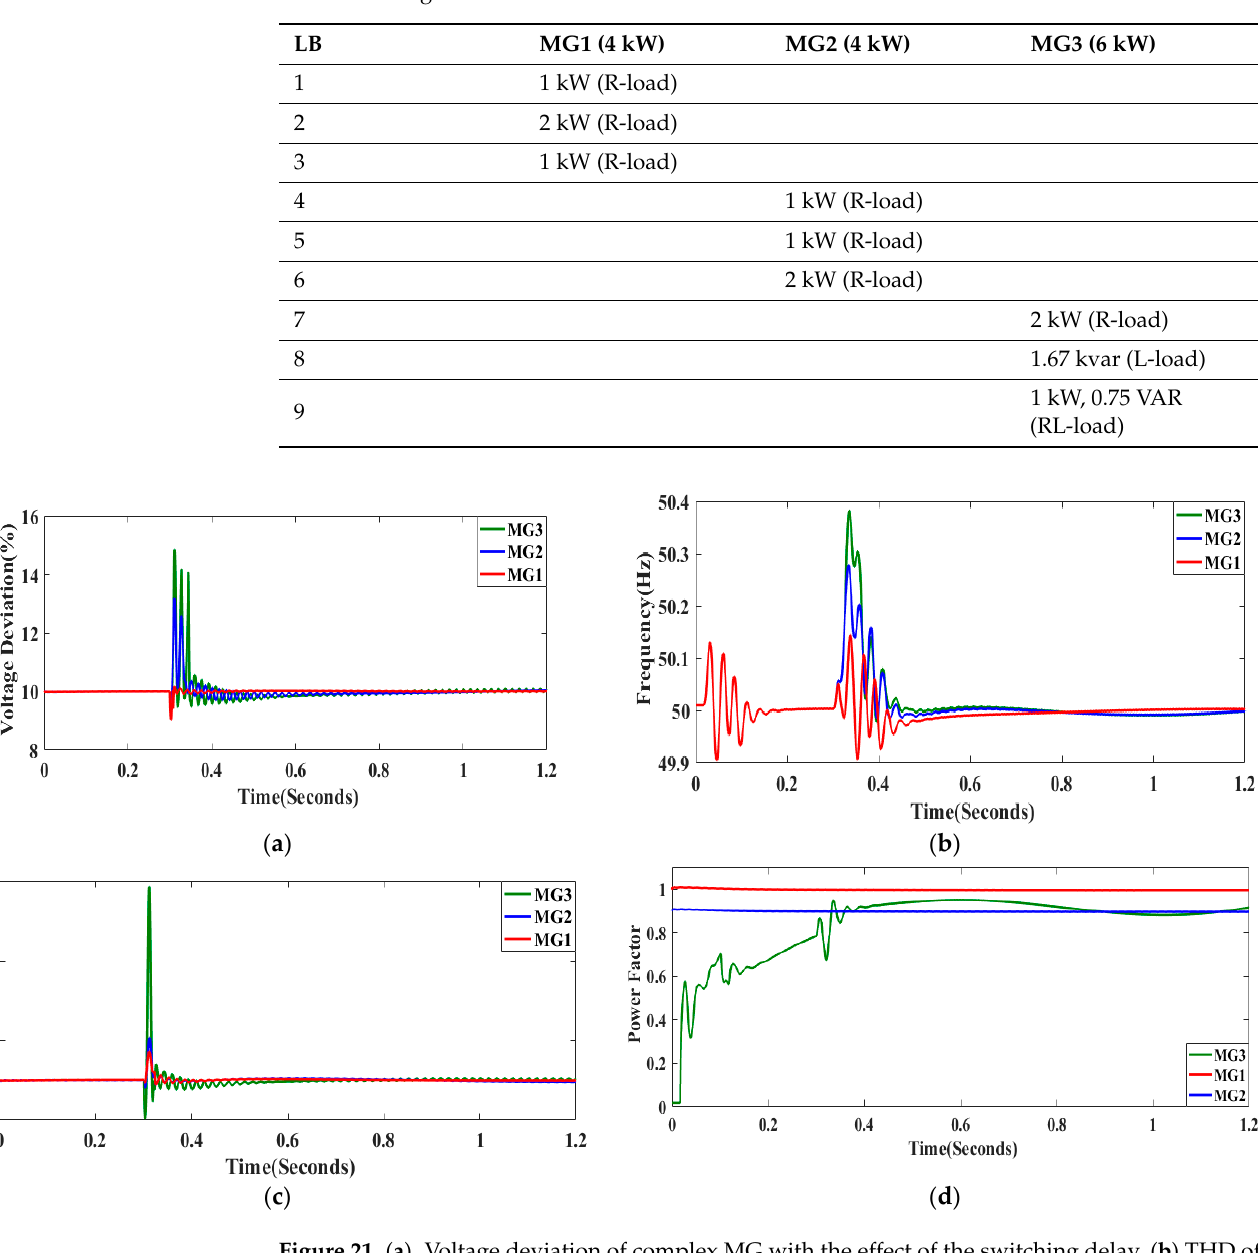
Table 10. Categories of loads associated in MG architecture.